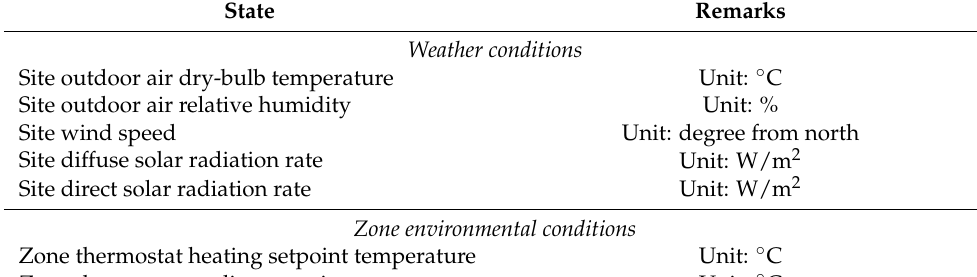
Table 2. A description of the states selected for reinforcement